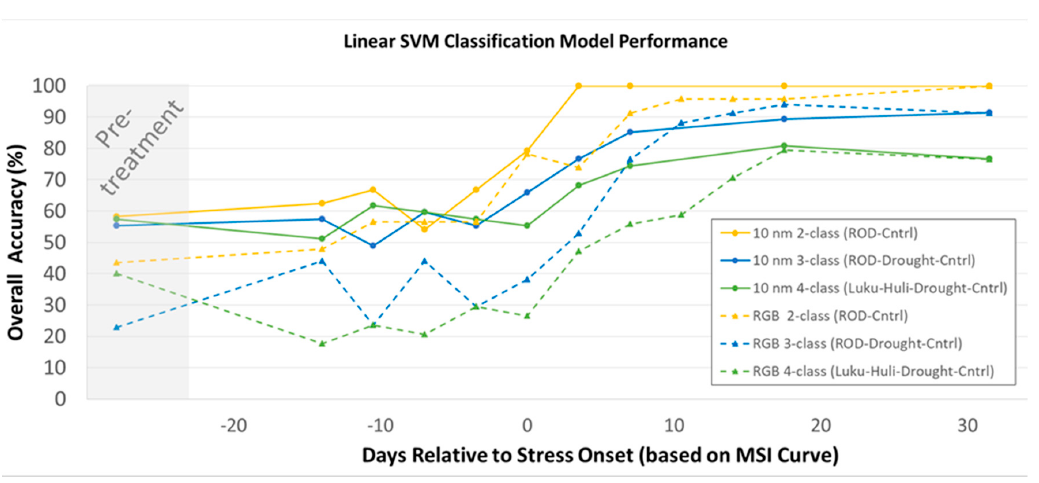
Figure 13. Overall support vector machine (SVM) model classification accuracy results for resampled 10 nm-resolution spectral data (ASD 10 nm, solid lines) and visible photographs (RGB, dashed lines) for two-, three-, and four-class models. Models were generated for pre-treatment and different points along the MSI stress curve trajectories, with zero corresponding to stress onset.